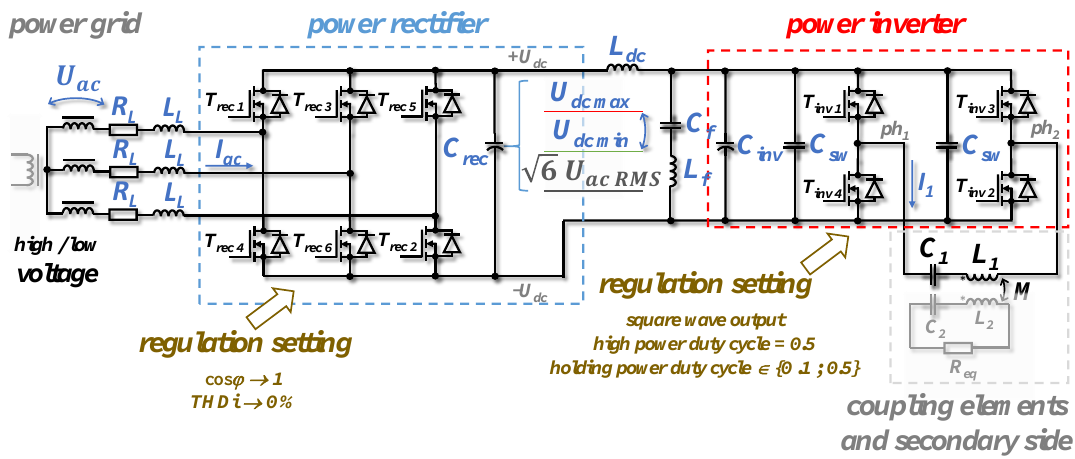
Figure 10. Recommended system configuration for high-power applications.